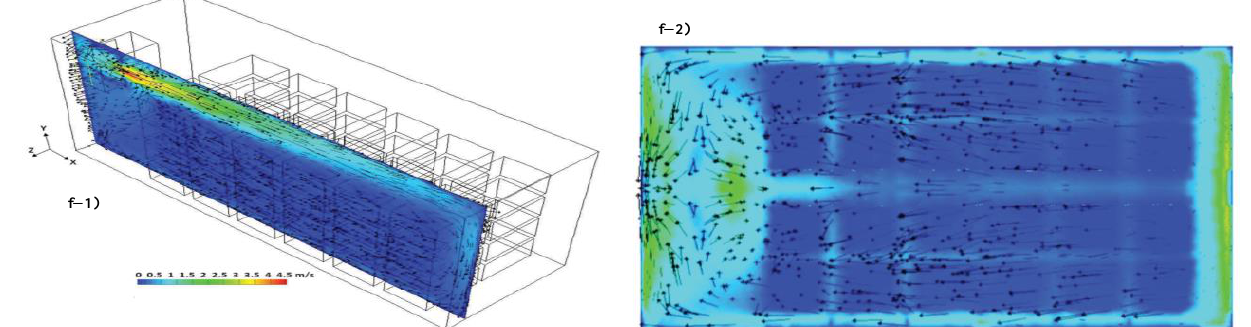
Figure 4. Airflow patterns inside a cooling unit for different cold chain links found in the literature ( a ) [33], ( b ) [28], ( c ) [51], ( d ) [78], ( e ) [63], and ( f ) [50] .